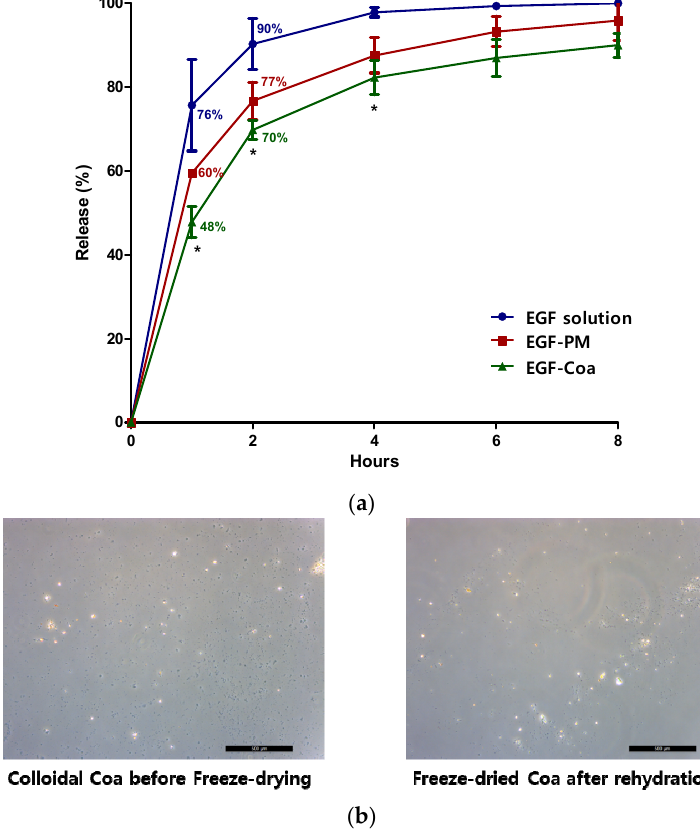
Figure 1. ( a ) In vitro release profiles of epidermal growth factor (EGF) solution, EGF-PM, and EGF-coacervate (EGF-Coa) at 32 °C determined by HPLC. The statistical difference was determined by one-way ANOVA with GraphPad Prism software (version 5.01). ( b ) Comparison of microscopic images of low molecular weight gelatin type A and sodium alginate (LWGA-SA) (1:0.4) coacervates before freeze drying and after rehydration of freeze-dried coacervates after one hour rehydration (Scale bar = 500 μ m).